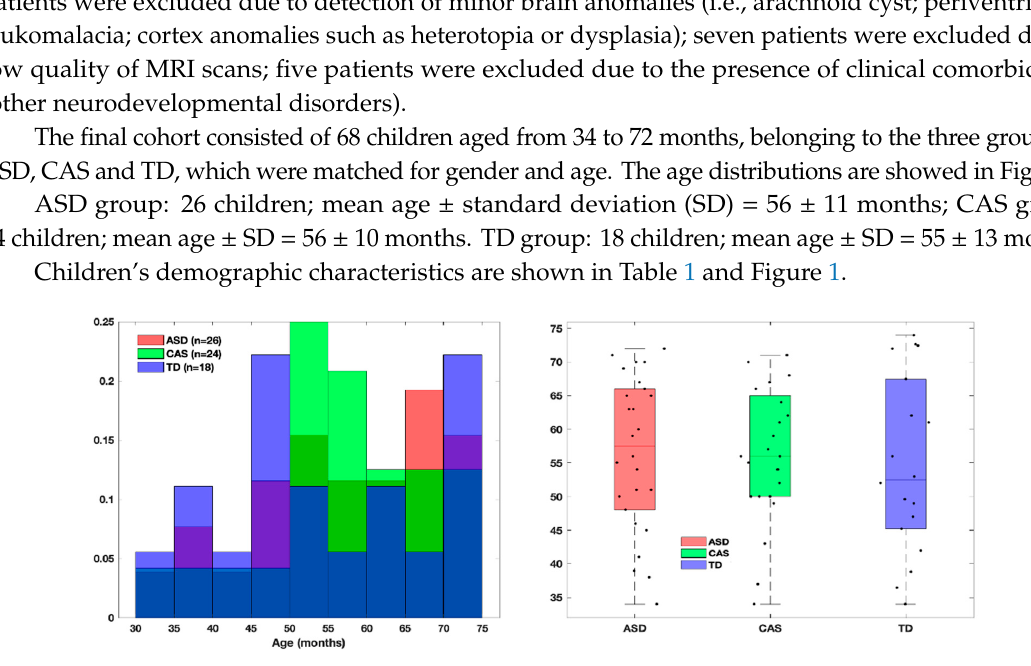
Figure 1. Age distribution of the subjects in the ASD, CAS and TD groups. The bar plot is shown on the left for the three groups, whereas the box plots with an overlay of the age value of the individual subjects, slightly scattered randomly along the x axis, are shown on the right. Abbreviations: ASD, Autism Spectrum Disorder; CAS, Childhood Apraxia of Speech; TD, Typical Development control. Table 1. Demographic characteristics of the cohorts of subjects with ASD, with CAS and TD subjects. The number of subjects in each subgroup is reported ( n ) together with the male/female percentage with respect to the total number of subjects in each cohort.